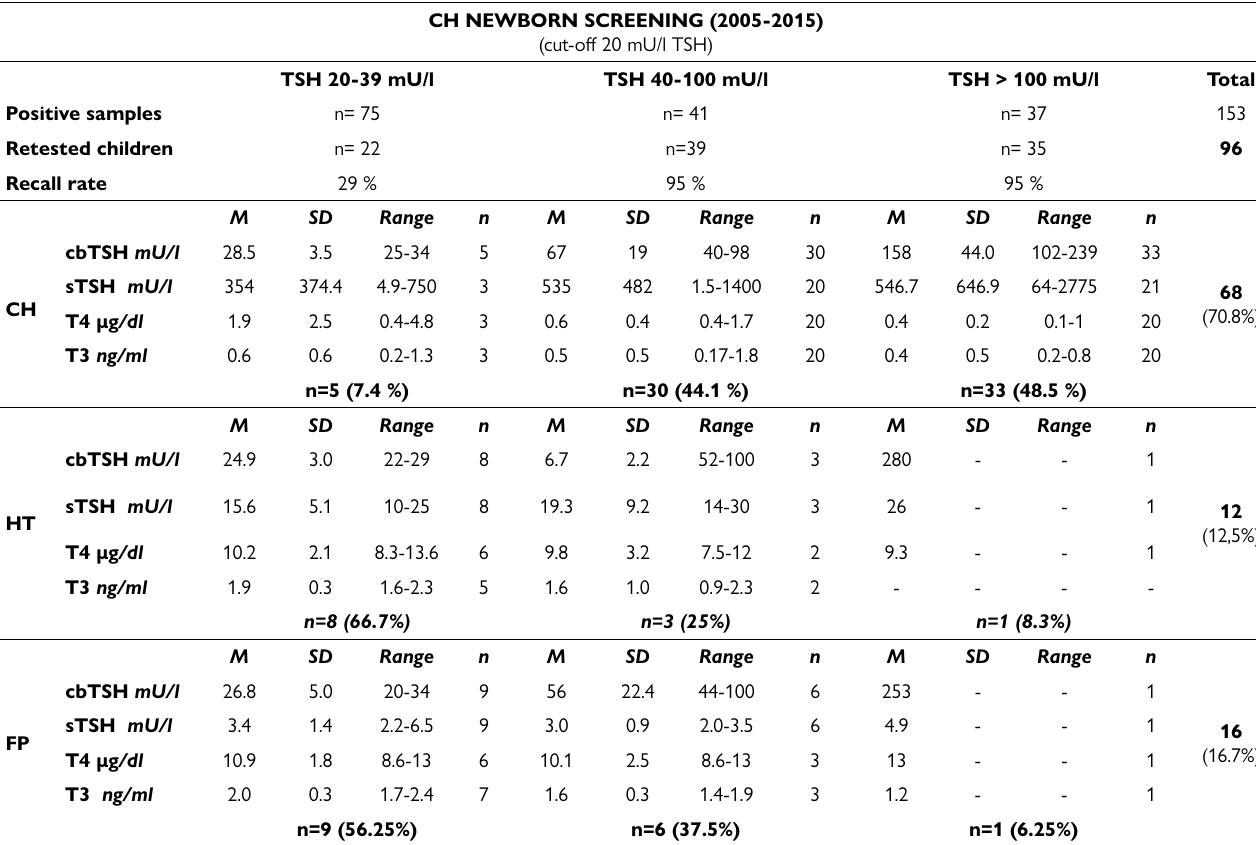
Table 2. Thyroid hormone profile of neonates positive at the CH screening, categorized in 3 groups depending on cord- blood TSH levels: 20-40, 40-100 and >100 mU/l, respectively. CH, congenital hypothyroidism; HT, hyperthyrotropinemia; FP, false positive; cbTSH, TSH from cord blood (eluate from filter-paper spots); sTSH: serum TSH at recall; T4, serum total thyroxine at recall; T3, serum total tri-iodothyronine at recall. M mean; SD, standard deviation; n, number of individuals. For reference ranges of serum TSH, T4 and T3 (see references 26-29). Reference ranges for sTSH: < 10 mU/l (Hubner et al 2002; Djemli et al., 2004; Kapelari et al., 2008, Rastogi & LaFranchi 2010), and <7 mU/l between 1-12 months of life (Hubner et al 2002; Djemli et al., 2004; Kapelari et al., 2008) for T4: 6.9-16 µg /dl (Rastogi & LaFranchi, 2010) and for T3: 0.9-2.4 ng/ml (Djemli et al 2004). CH NEWBORN SCREENING (2005-2015) (cut-off 20 mU/l